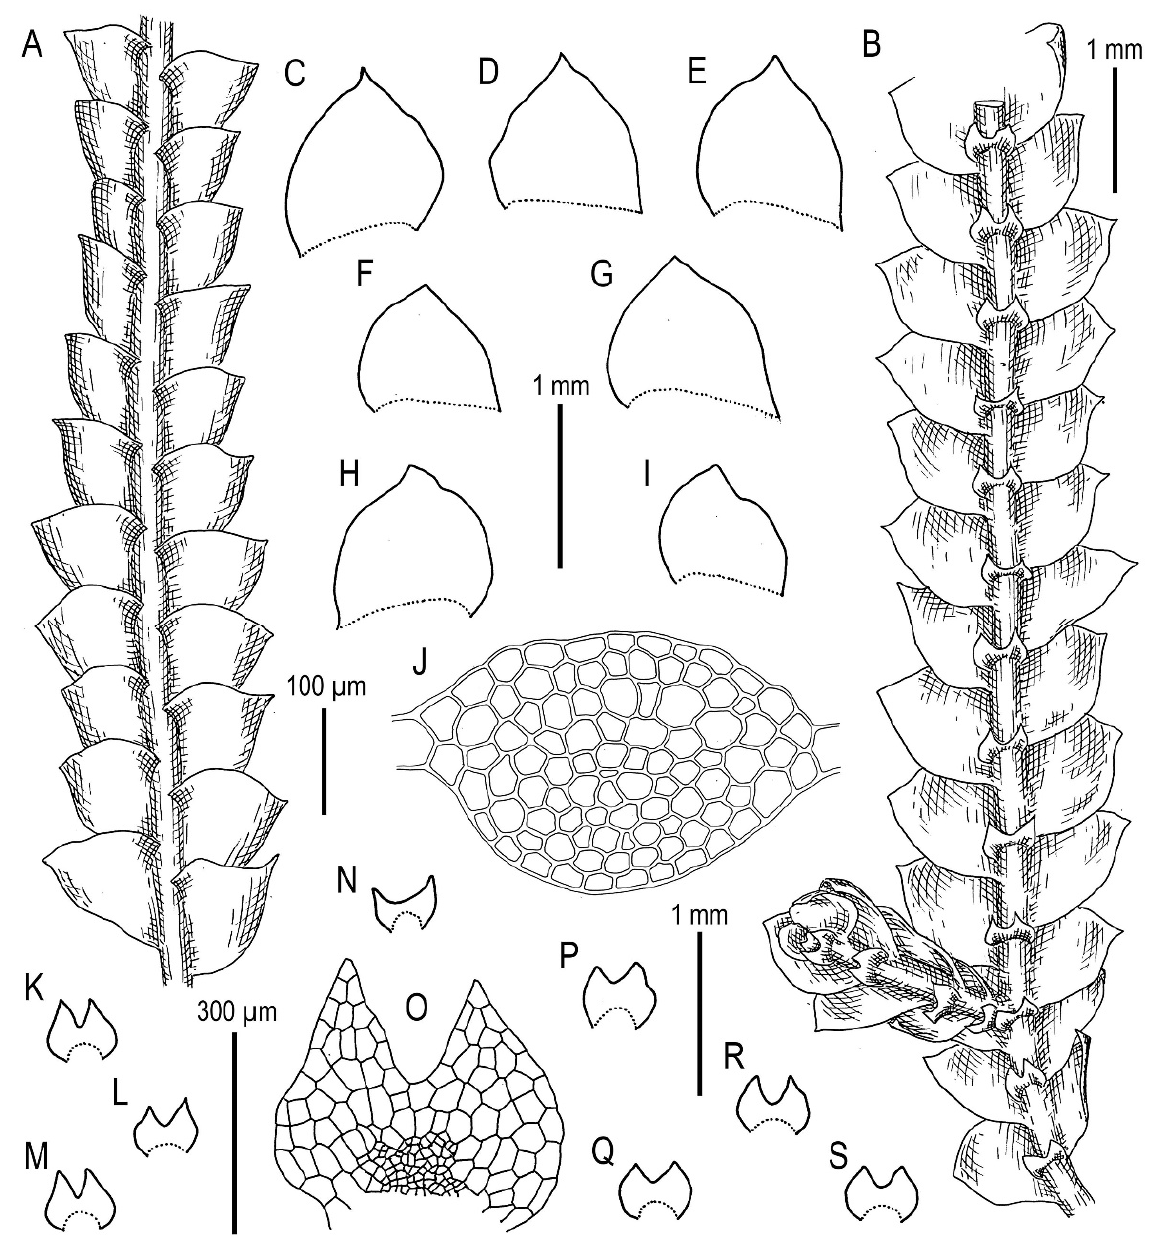
Figure 14. Calypogeia pseudocuspidata Bakalin, Frank Müll. et Troizk., sp. nov. : ( A ) Plant habit, fragment, dorsal view; ( B ) Plant habit, fragment, ventral view; ( C – I ) Leaves; ( K – S ) Underleaves; ( J ) Stem cross section. All from V-21-17-18 (VBGI).